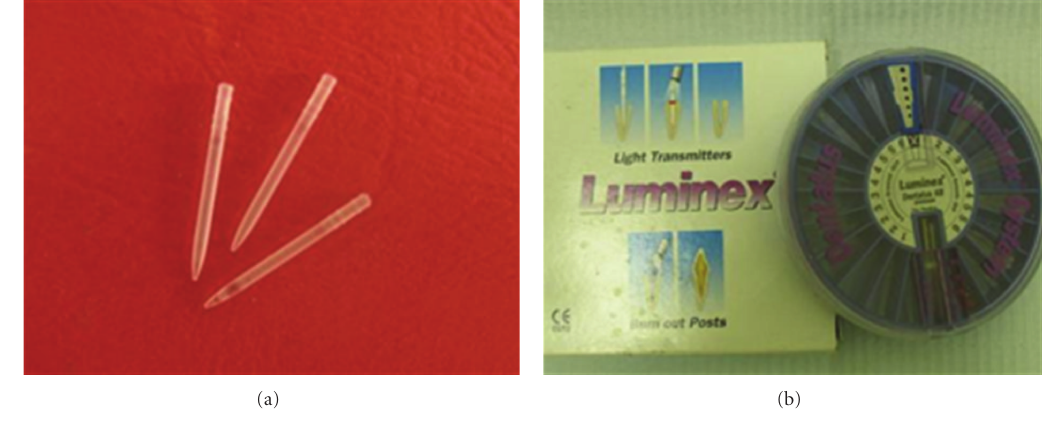
Figure 2: Plastic Transilluminating post (Luminex post system).